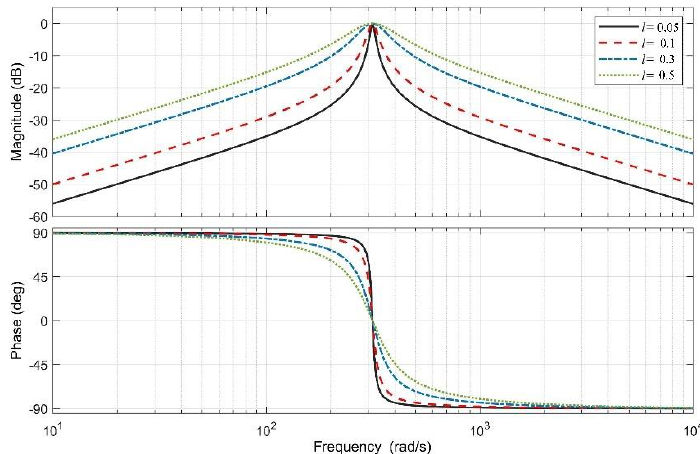
Figure 7. Bode diagram of SOGI.